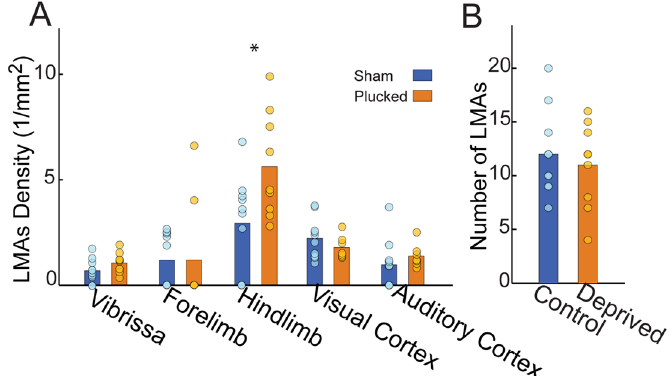
Figure 3. Lemtomeningeal anastomoses density was higher in the hindlimb representation of somatosensory cortex, but was not altered by sensory deprivation. ( A ) Density of LMAs for five cortical sensory areas. ( B ) Comparison of the total number of LMAs in sham-treated and plucked mice within the anatomically-identified barrel, forelimb, hindlimb areas. The LMA count spans a factor of three. Bars show means across animals within a treatment group, circles are data points from individual animals.